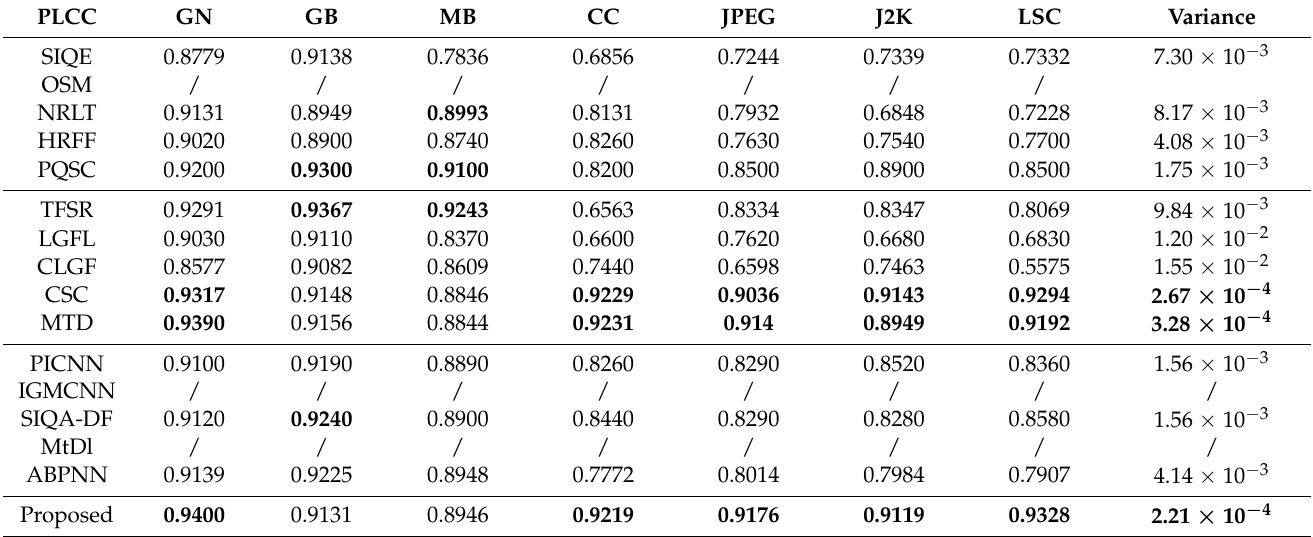
Table 4. PLCC results of different distortion types for the proposed and other methods on SIQAD.